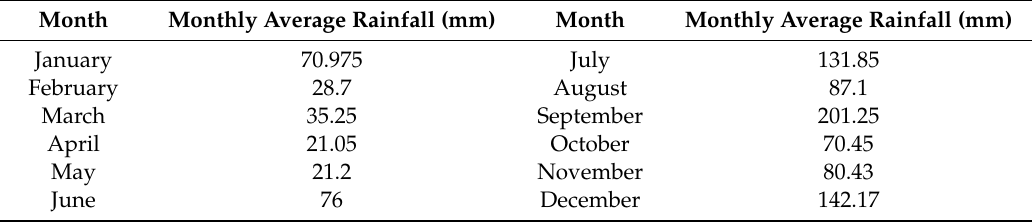
Table 1. Average monthly rainfall from 2014–2017 in Mulanay,